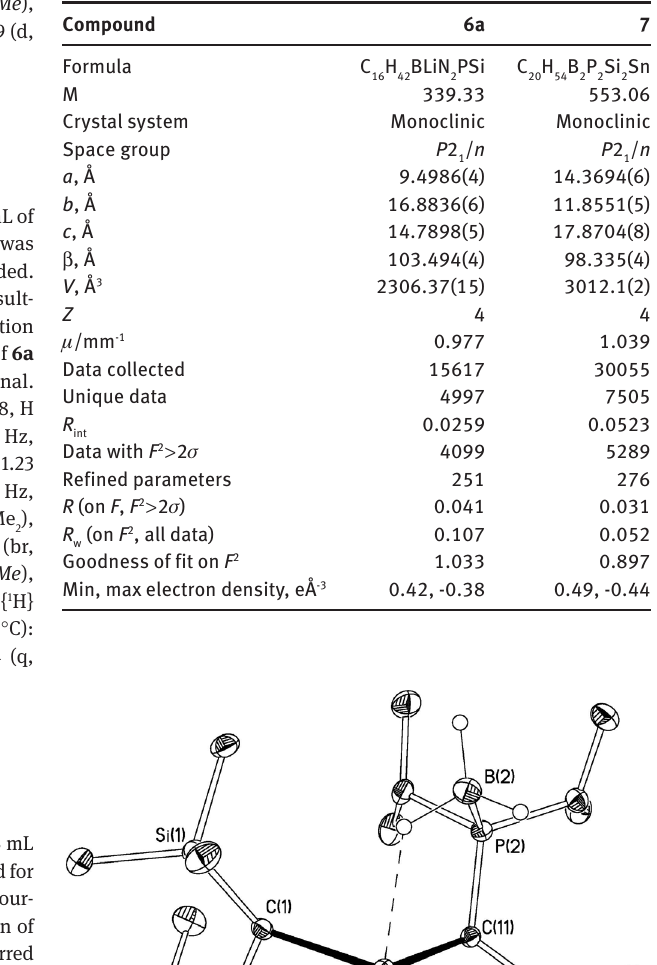
Table 1 Crystallographic data for compounds 6a and 7 .